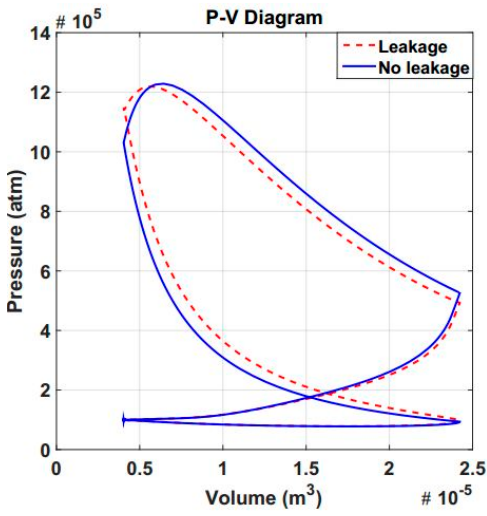
Figure 16. P-V diagram over one cycle (100 Hz).